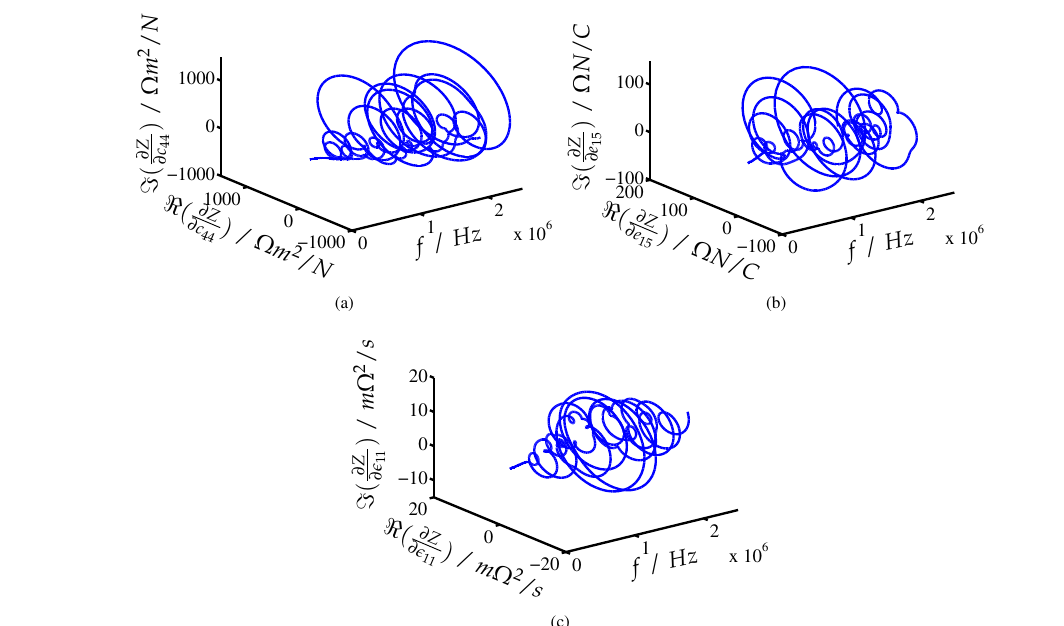
Figure 6. Sensitivity of the impedance for the resulting geometry of the ring electrodes shown in Table 1 to various material parameters against frequency w.r.t. (a) c 44 , (b) e 15 , and (c) ε 11